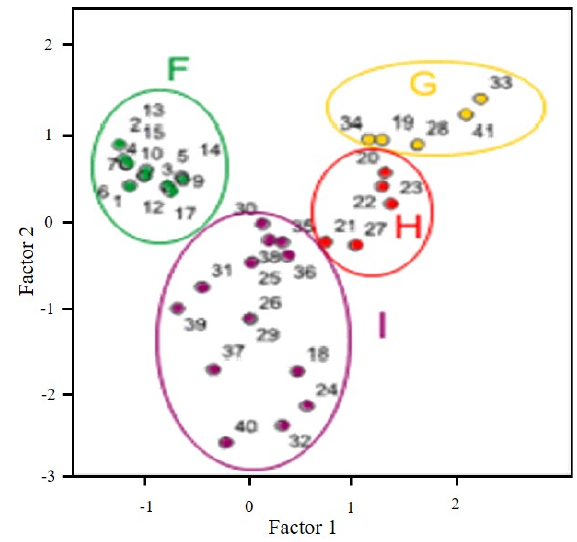
Figure 3. Principal Component Analysis for white wines.